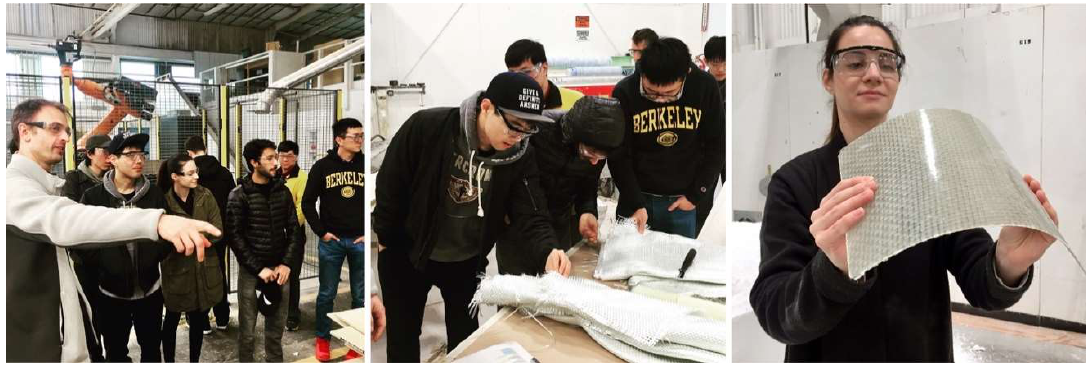
Figure 3. At UC Berkeley’s Botanical Garden, students investigate the morphology of living plants.